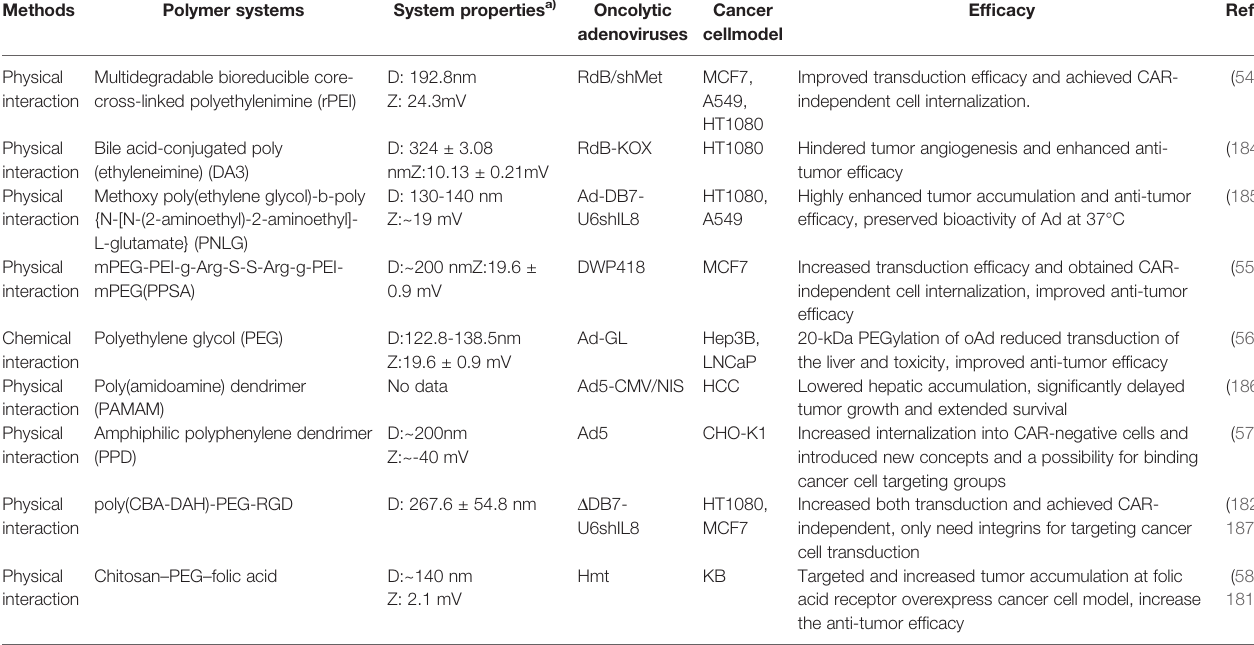
TABLE 2 | Summary of recent research on different polymeric systems for